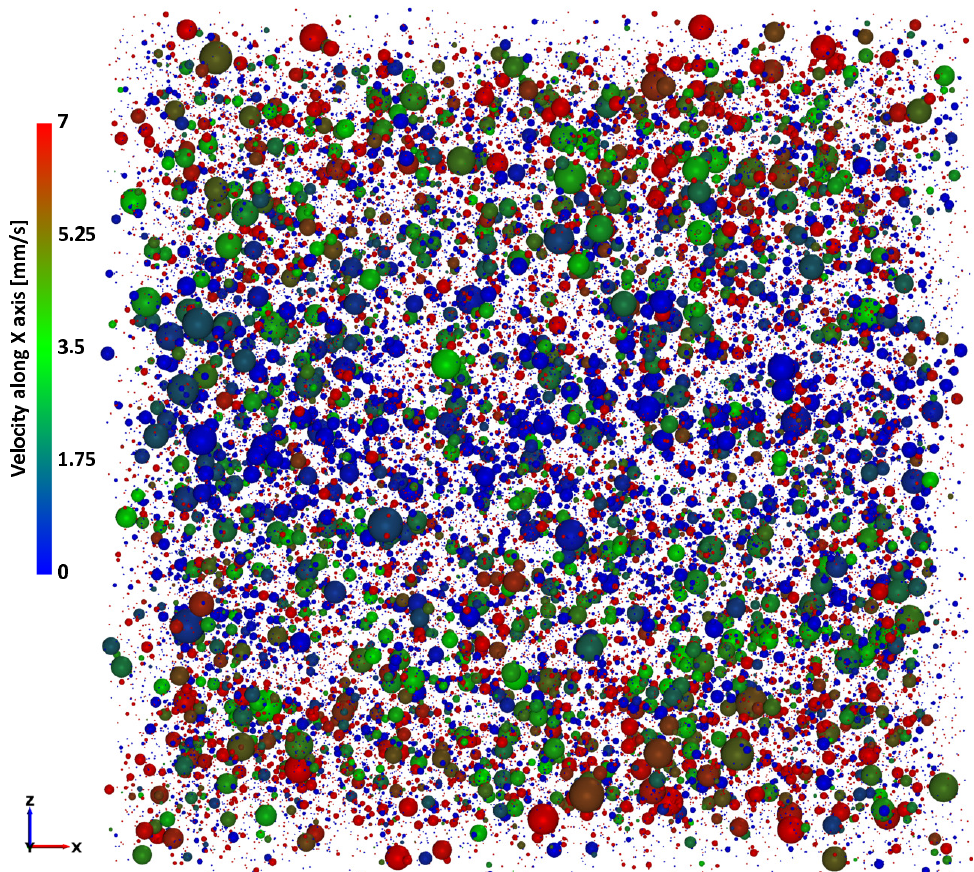
Figure 3. General view of one of the simulated DEM scenes at time 0.011 s. The color of the particles corresponds to their speed along the X axis, caused by both shear and Brownian